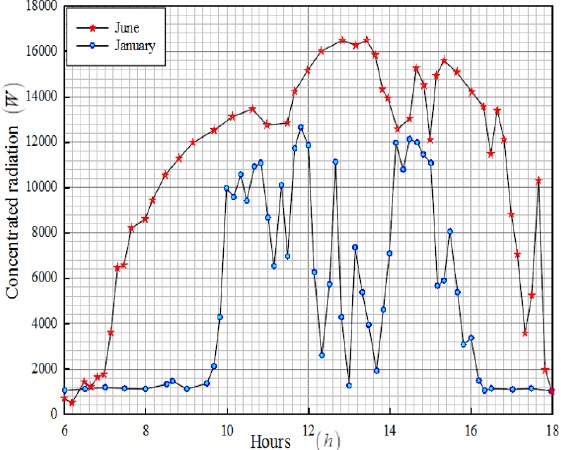
Figure 3. Variations of the concentrated radiation vs. time in January and June.